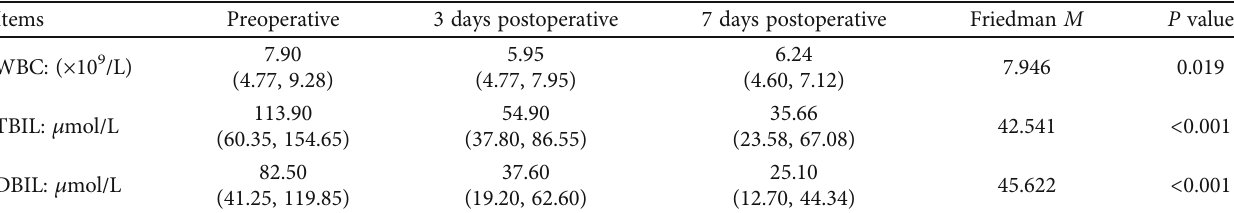
Table 2: The comparison of WBC, TBIL, and DBIL.